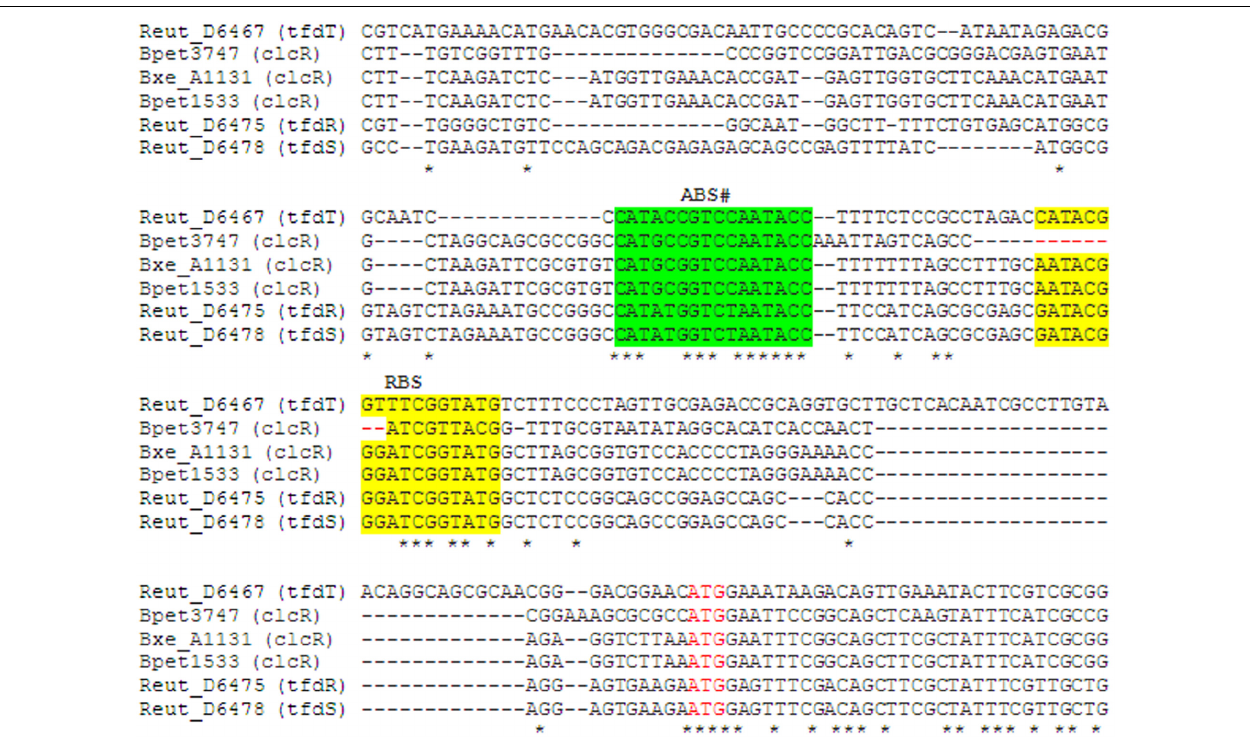
FIGURE 9 | Multiple alignment of the upstream regions of regulatory genes clcR , tfdR , tfdS , tfdT. ABS is highlighted with green, RBS – with yellow, start codon ATG is marked with red font. Asterisks mark completely conserved positions of the alignment. #Since genes of TFs are divergent to their regulated genes, ABS sequences here are in reverse complement compared to the sequences (ABS in catB , clcA upstream regions) described earlier (Parsek et al., 1994; Chugani et al., 1997, 1998; Tover et al., 2000,